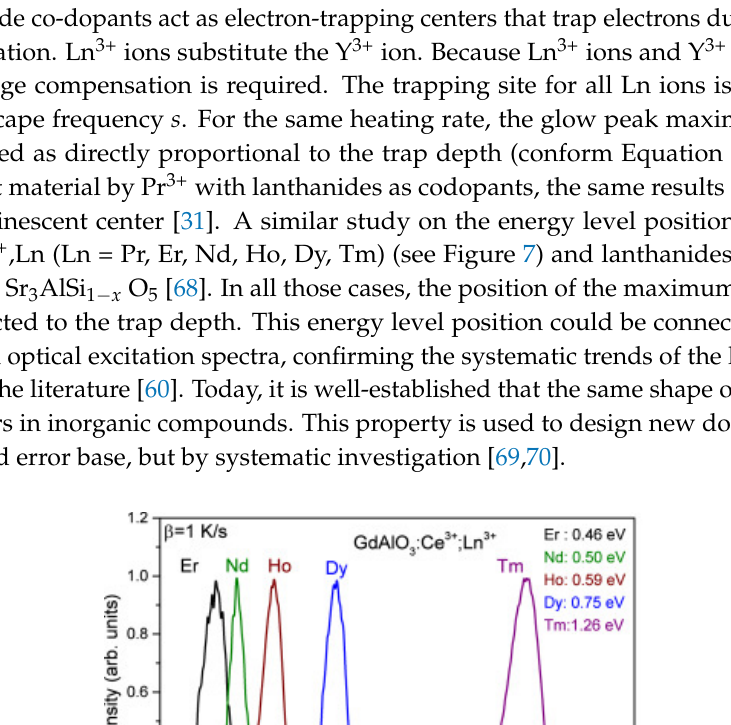
Figure 8. Thermoluminescent excitation spectrum ( a from You et al. [72]) and optical absorption spectrum ( b , adopted from Hamilton et al. [73]) of YAG:Ce 3+ . Note the absence in the 5d 1 band in the TLES spectrum.